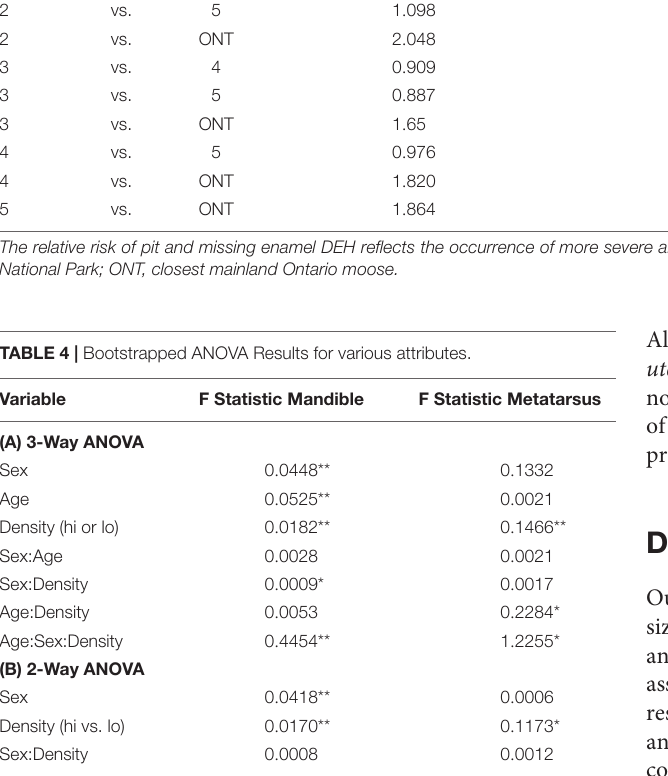
TABLE 3 | Relative risk assessment of incurring one or more dental enamel hypoplasias (DEH) on all teeth as well as teeth formed after weaning across time and localities. Period vs. Period X times the risk of 1 + DEH X times the risk of 1 + post-weaning DEH X times the risk of pit or (all morphologies) (all morphologies) missing enamel morphology